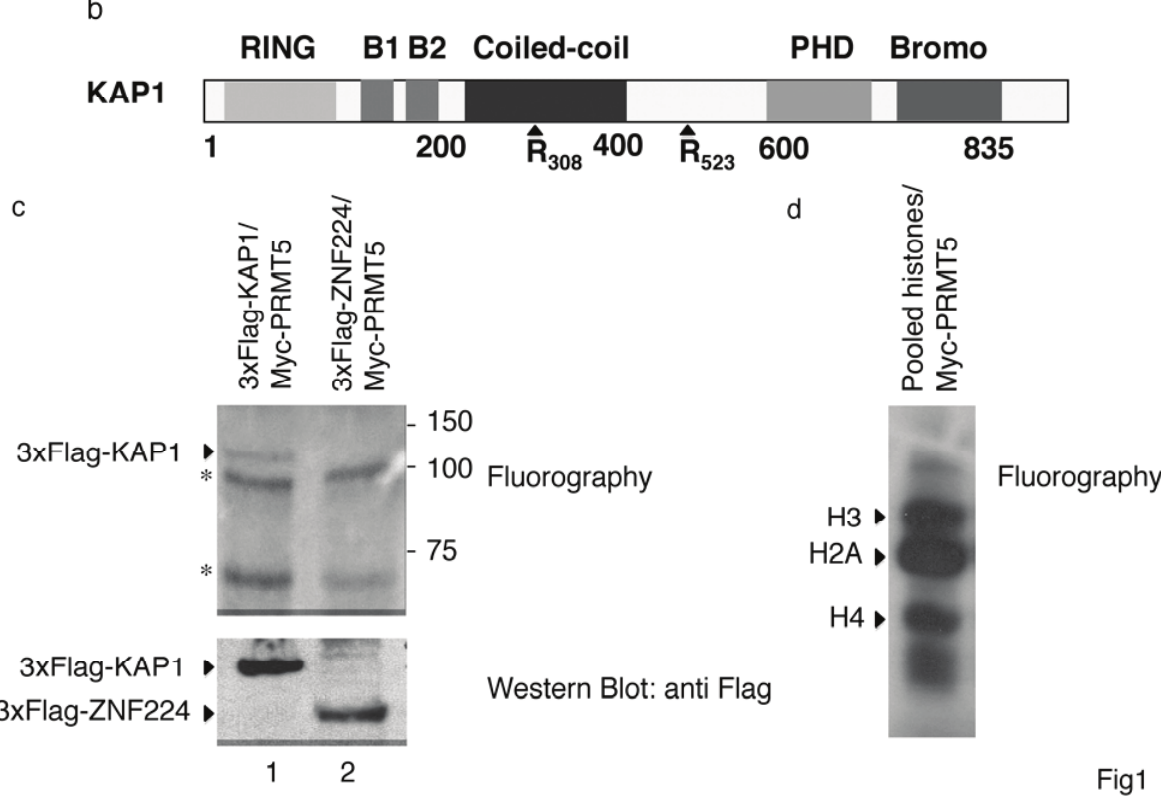
Figure 1. KAP1 interacts with PRMT5 and is a substrate for PRMT5-mediated methylation. ( a ) KAP1 interacts with PRMT5 protein. Flag-tagged KAP1 was immunoprecipitated from HEK293 cells with anti-Flag antibody or control immunoglobulin (IgG), as indicated. The specific interaction of KAP1 with the endogenous PRMT5 protein was detected by Western blot analysis with anti-PRMT5 antibody. Relative amount of immunoprecipitated Flag-KAP1 was visualized by Western blot analysis with anti-Flag antibody; ( b ) A schematic representation of the domains in the KAP1 protein. The arginine residues at positions 308 and 523 are potential methylation sites for PRMT5; ( c ) KAP1 is an in vitro substrate of PRMT5. The recombinant proteins Flag-KAP1 and Flag-ZNF224 were purified from hypomethylayed HEK293 cells and subjected to an in vitro methylation assay using recombinant Myc-PRMT5 and [3H]-AdoMet. The 3H-labeled proteins were resolved by SDS-PAGE on an 8% gel and visualized by fluorography. The asterisks indicate nonspecific bands. An aliquot of the substrates used in the in vitro methylation reaction were immunoblotted with anti-Flag antibody; ( d ) Pooled histones, used as positive control for the in vitro methylation assay, were visualized by fluorography. Results shown in Figure 1 are representative of two independent